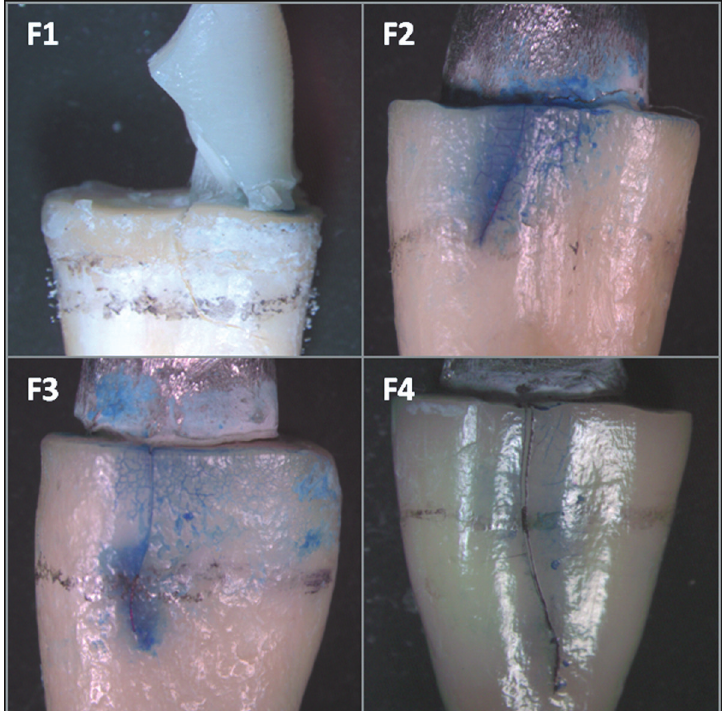
Figure 2- Photographs from stereomicroscopy of the failure types. F1) core fracture; F2) root fracture up to the simulated bone level; F3) root fracture up to 1 mm below the simulated bone level; F4) root fracture more than 1 mm below